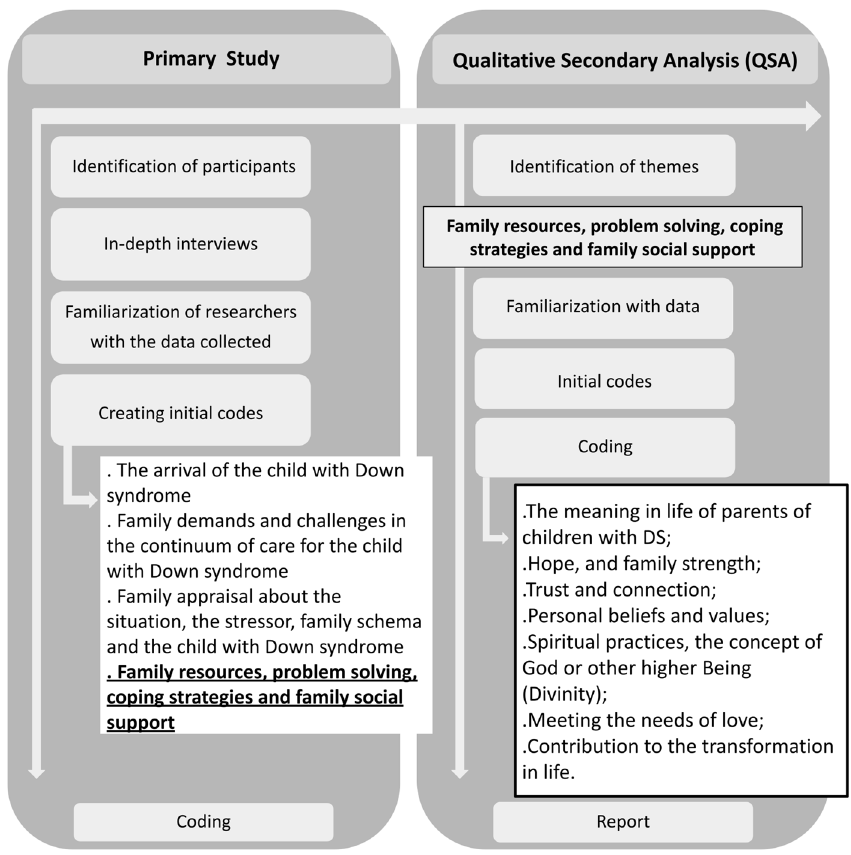
Figure 1. Flowchart of the work process of the original study and the QSA.